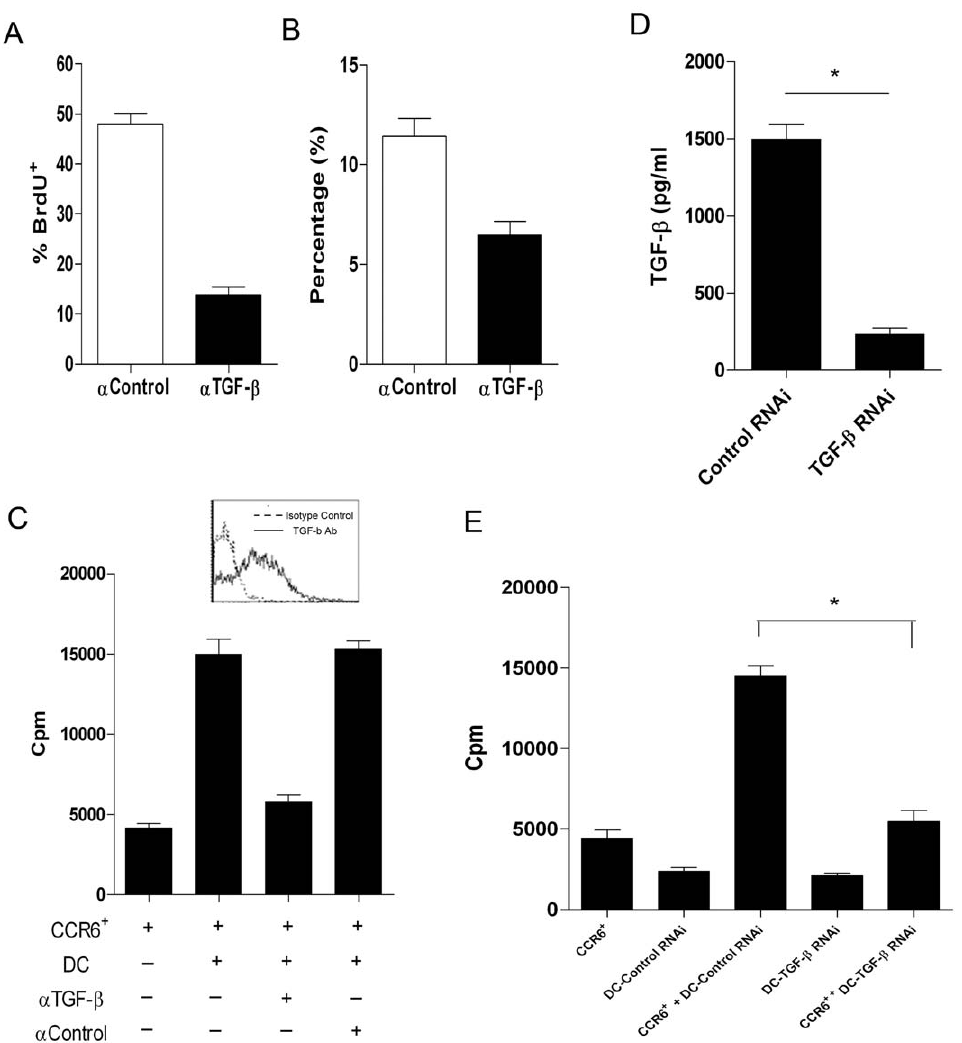
Figure 4. DCs triggerred the proliferation of CCR6 + Treg in a TGF- b dependent manner. The 4T1-bearing mice were treated with 2 mg BrdU i.p. every other day up to a cumulative dose of 8 mg BrdU. These mice also were simultaneously intratumorally injected 0.1-ml aliquots of Anti- TGF- b antibody (50 ug) ( & ) ( n =6) or rat IgG2a isotype control ( % ) ( n =6) every other day. 8 hrs after last injection of BrdU, The TILs were collected. The proliferation ( A ) and proportion ( B ) of CCR6 + Tregs in TILs were analyzed by FACS and calculated. ( C ) Proliferation of CCR6 + Tregs after culturing with DCs at a ratio of 1:2 in the presence of anti-TGF- b or isotype control antibody (10 ug/ml) for 3 days. ( D ) CD11c + DCs were purified from TILs by MACS. 1 6 10 5 DCs was cultured and transfected with TGF- b RNAi or Scramble control. 72 hrs later, the supernatant concentration of TGF- b were determined by ELSA assay. ( E ) 1 6 10 5 CCR6 + Tregs were cocultured with DCs transfected with TGF- b RNAi or scramble control at a ratio of 1:2. 72 hrs later, the proliferation of CCR6 + Tregs was determined. * p ,